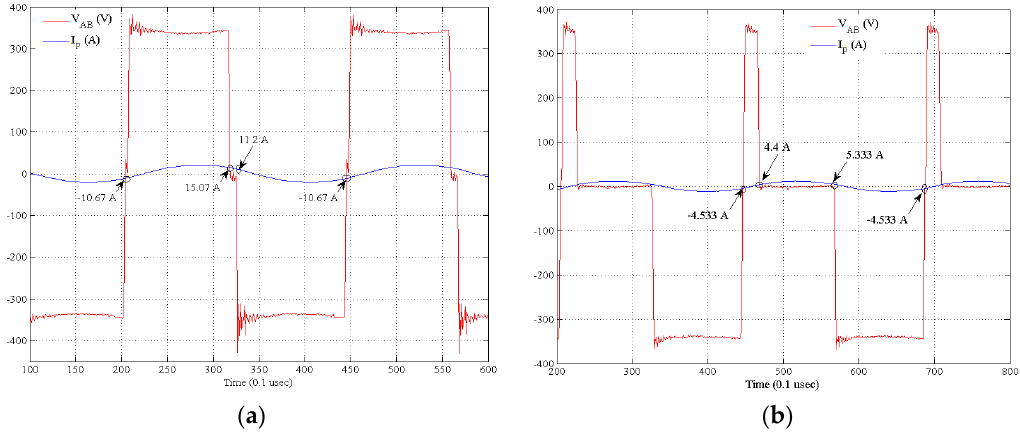
Figure 15. ( a ) Waveform for 168 V reference voltage, 7.84 Ω load; ( b ) Waveform for 92 V reference voltage, 7.84 Ω load.